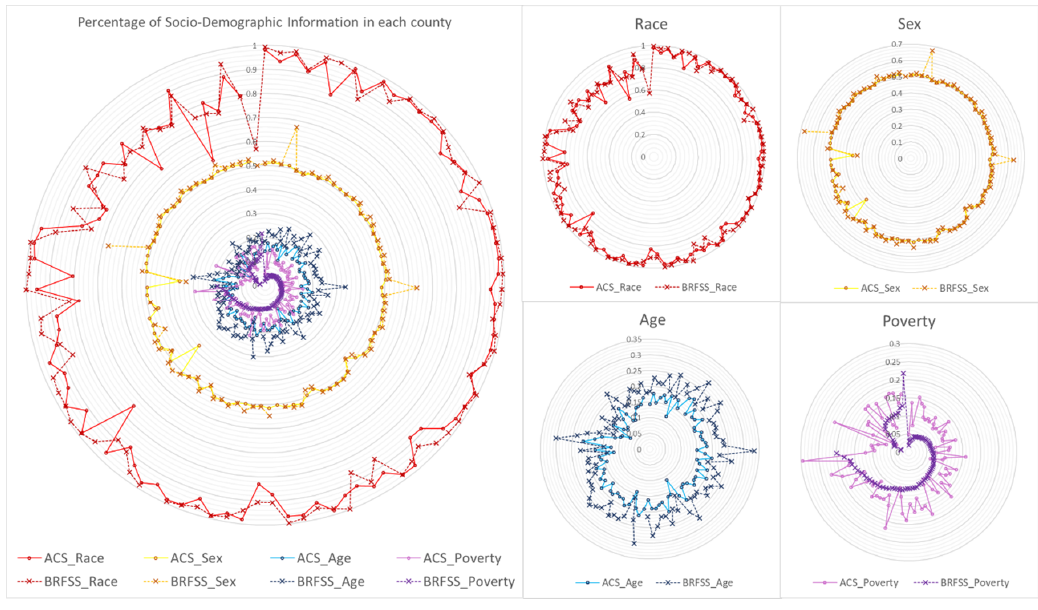
Figure 2. Sociodemographic comparison between Illinois County Behavioral Risk Factor Surveys and American Community Survey data.